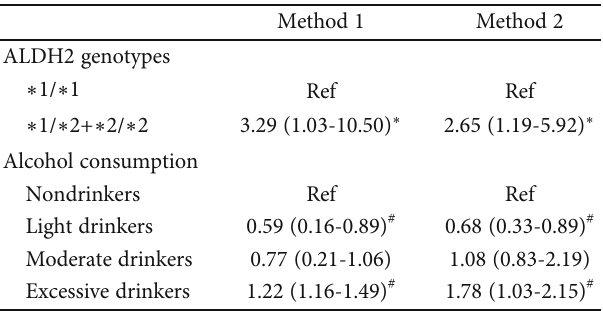
a Models were adjusted for age, gender, and education. ∗ p < 0 : 05 vs.